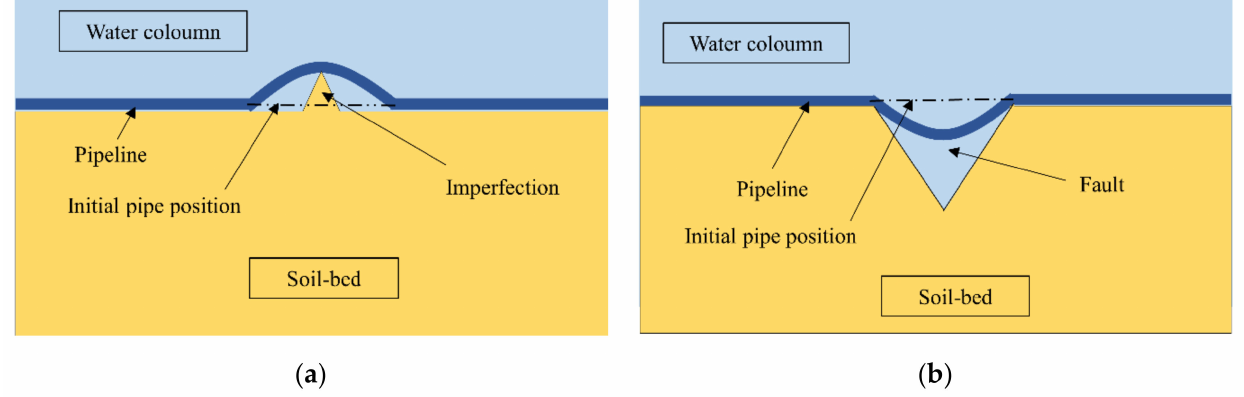
Figure 1. Vertical displacement of pipeline due to presence of ( a ) initial imperfection and ( b ) fault in the